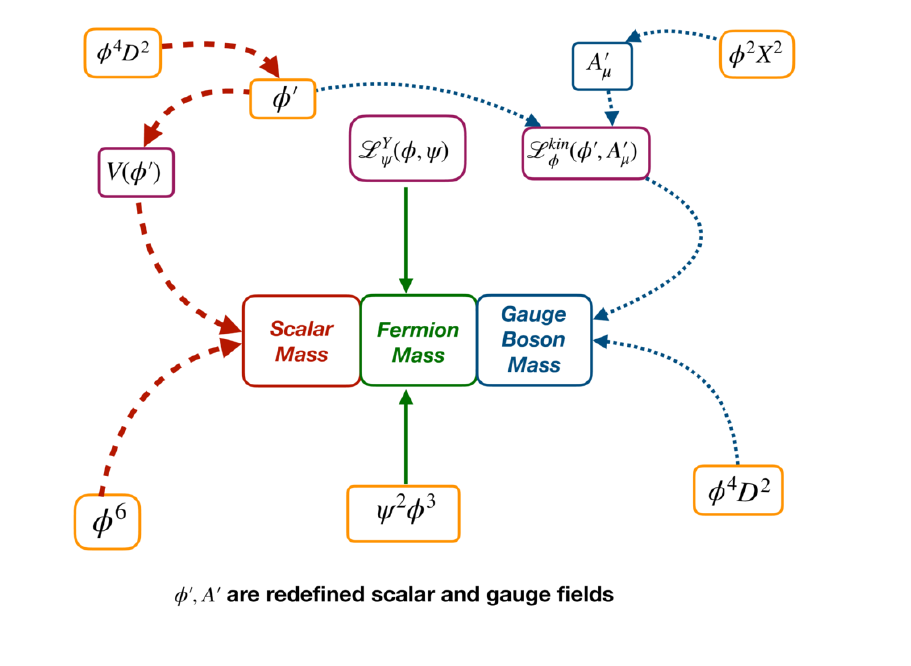
Figure 4. Trajectories outlining the impact of effective operators on the